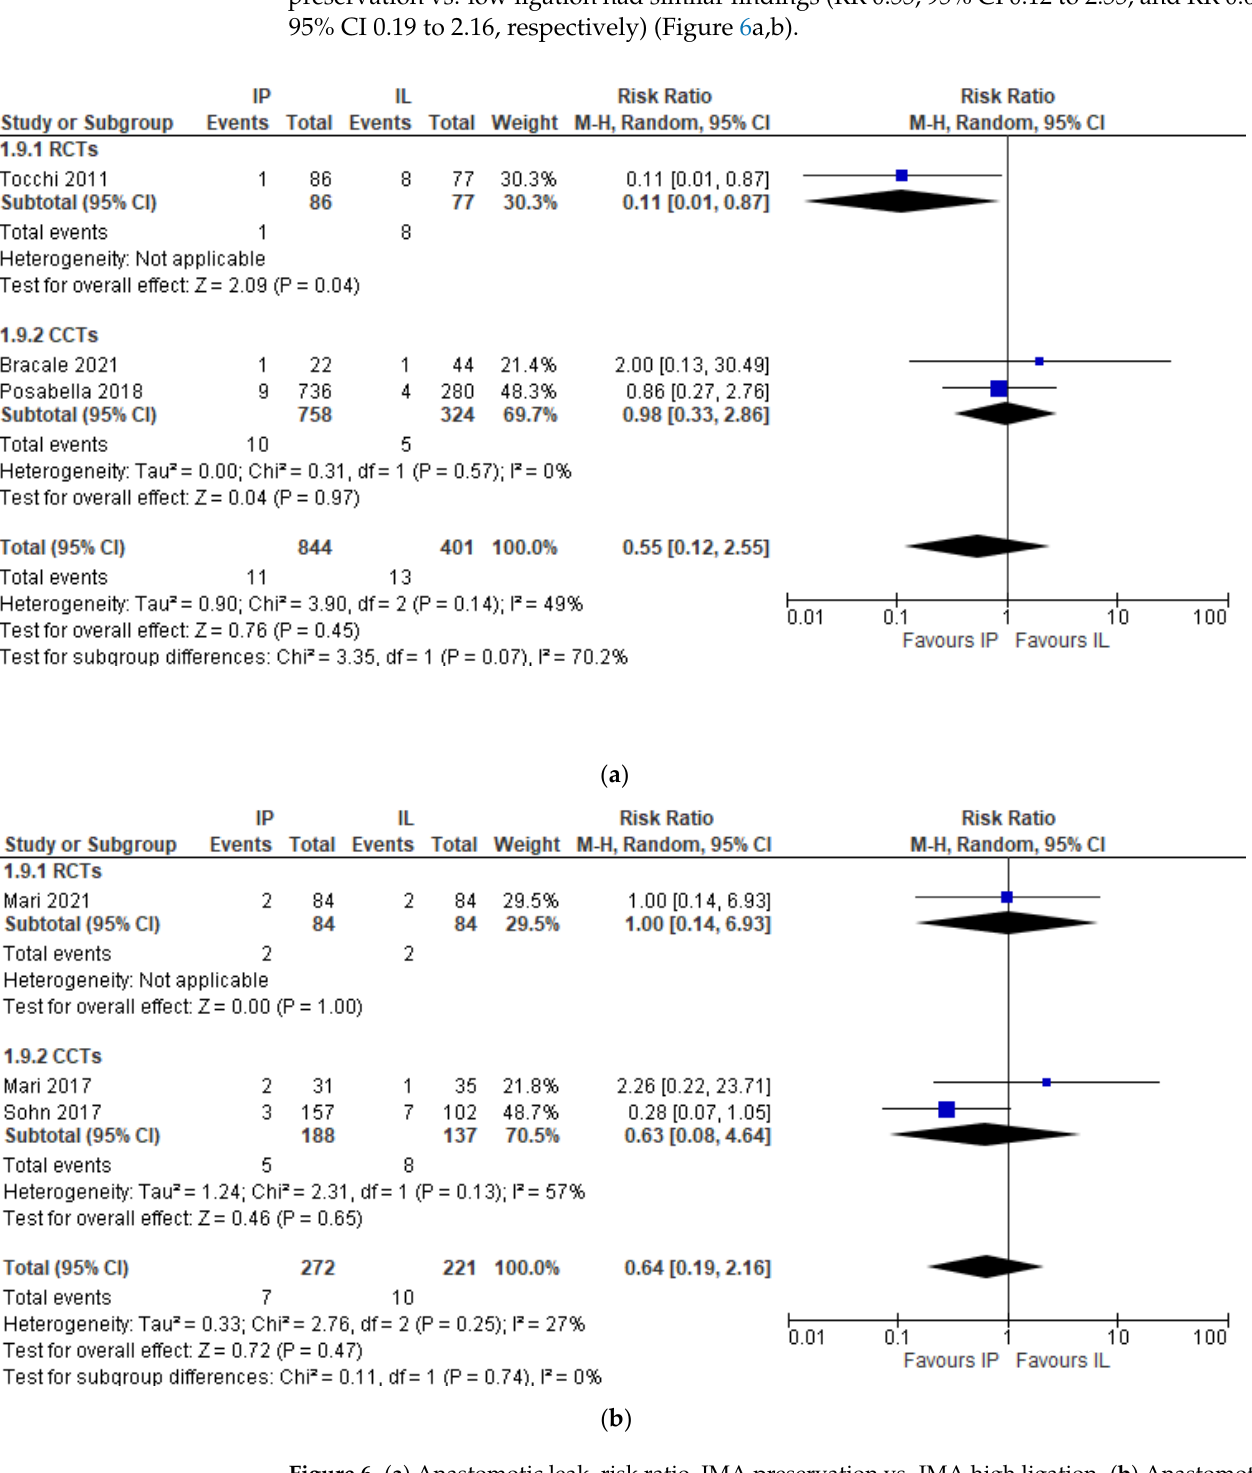
Figure 5. Anastomotic leak risk ratio in the laparoscopic sub-group.